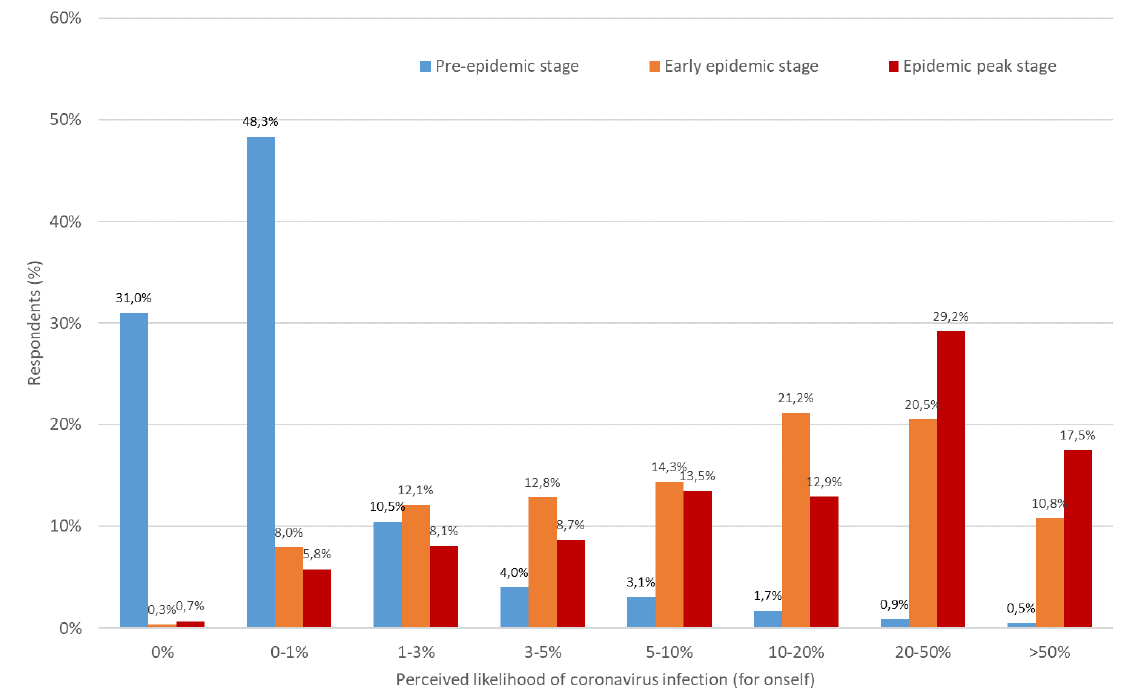
Figure 1. Personal perceived likelihood of becoming infected with COVID-19 at the pre-, early and peak epidemic stages.